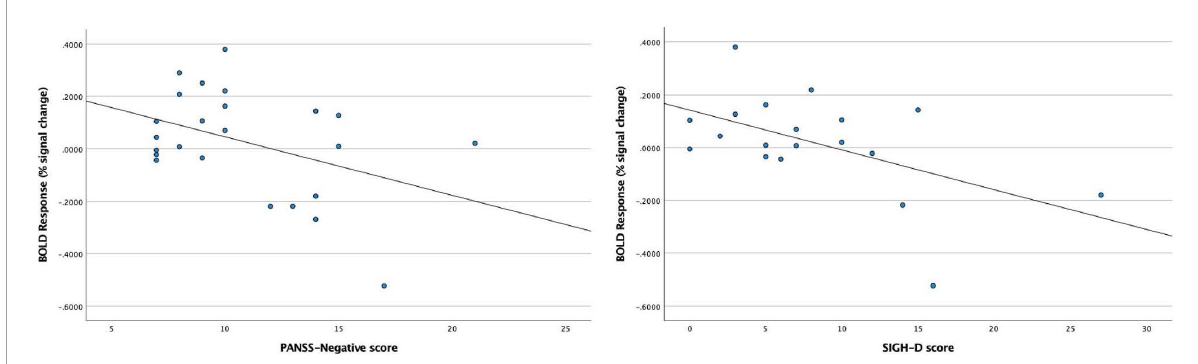
FIGURE5 Significant negative correlations between blood oxygen level-dependent (BOLD) response to 40-Hz stimuli in the right Brodmann areas 41 and 42 and PANSS-Negative scores (rho = –0.413, p = 0.045) in the BD patients, and between the BOLD response to 40-Hz stimuli in the right Brodmann areas 41 and 42 and SIGH-D scores (rho = –0.530, p = 0.020) in the BD patients.